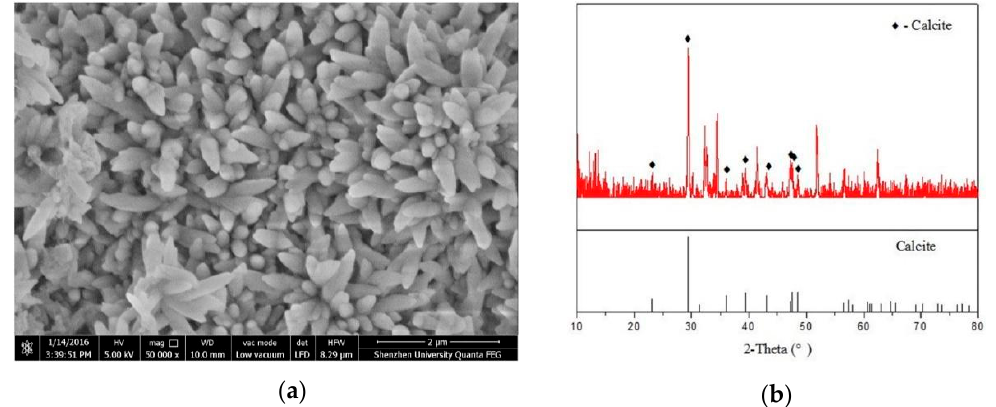
Figure 18. Description of the flow-like crystal ( a ) SEM image; and ( b ) XRD results of the surface of the sample obtained by method II. Reproduced with permission from [116], Elsevier, 2017.